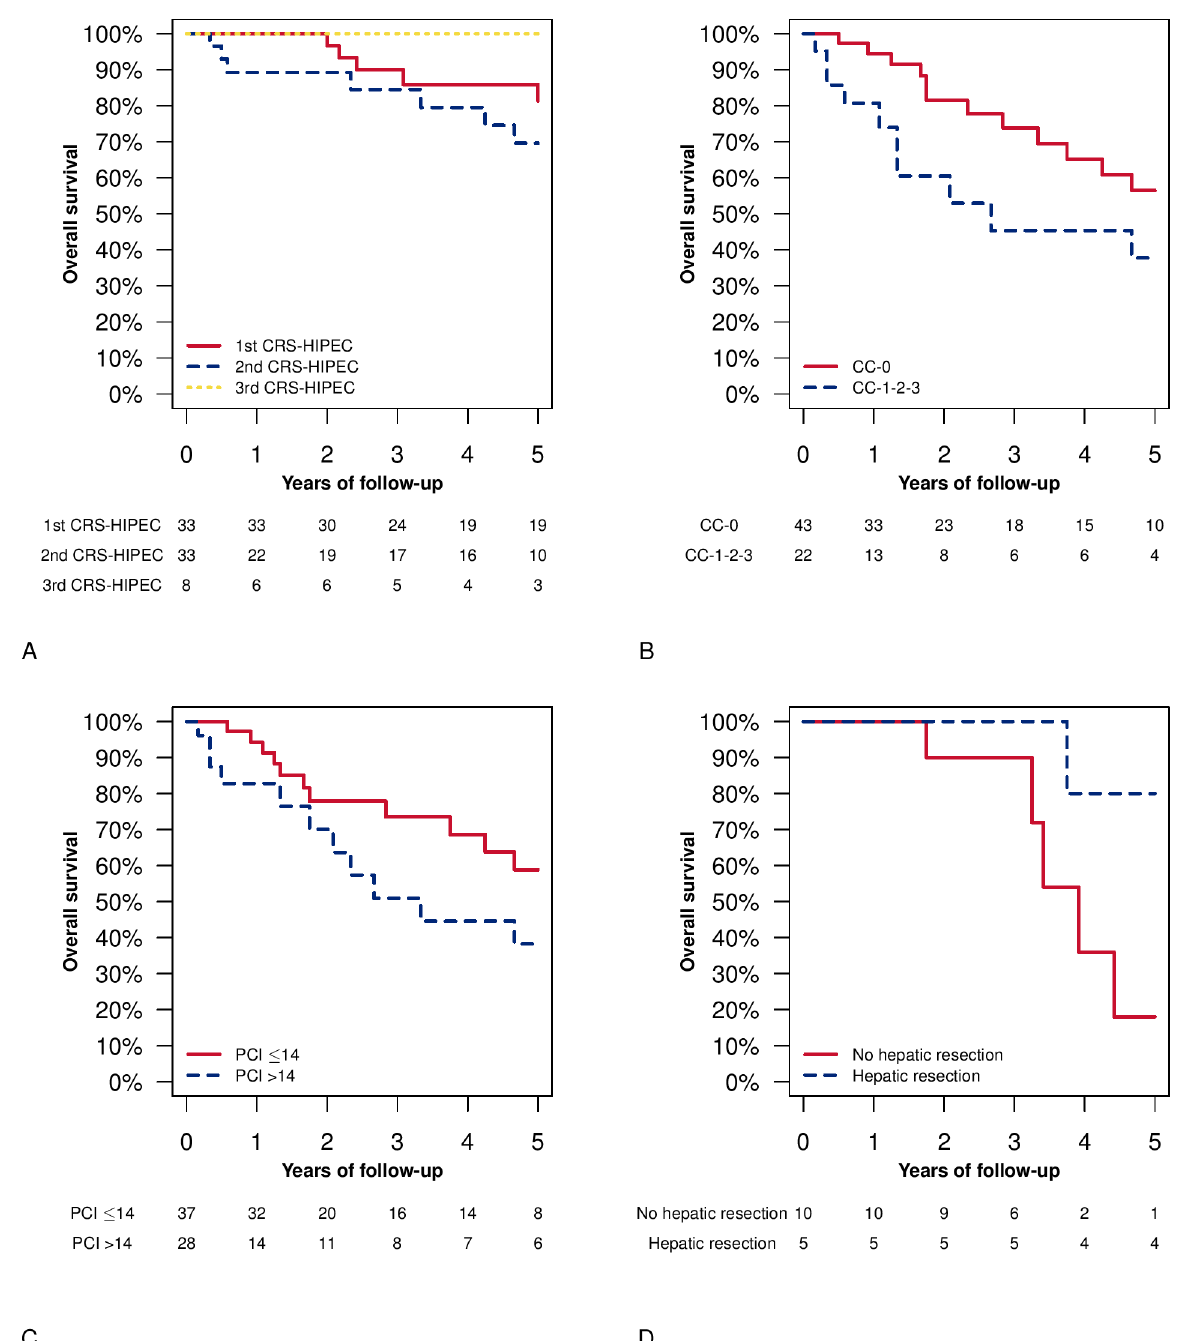
Figure 2. Overall survival Kaplan–Meier plots. Panel ( A ) overall survival after the first, second, and third CRS and HIPEC procedure in the patients with pseudomyxoma peritonei (PMP). Log-rank test: 1st CRS and HIPEC vs. 2nd CRS and HIPEC p = 0.254; 1st CRS and HIPEC vs. 3rd CRS and HIPEC p = 0.336; 2nd CRS and HIPEC vs. 3rd CRS and HIPEC p = 0.199. Panel ( B ) completeness of cytoreduction (CC) of the second procedure and overall survival from the second CRS and HIPEC (log-rank test p = 0.061). Panel ( C ) peritoneal cancer index (PCI) is subdivided according to the median value of the distribution at the time of the second procedure and overall survival, starting from the second CRS and HIPEC (log-rank test p = 0.107). Panel ( D ) overall survival from the diagnosis in patients treated during any procedure with hepatic parenchymal resection (log-rank test p = 0.059).